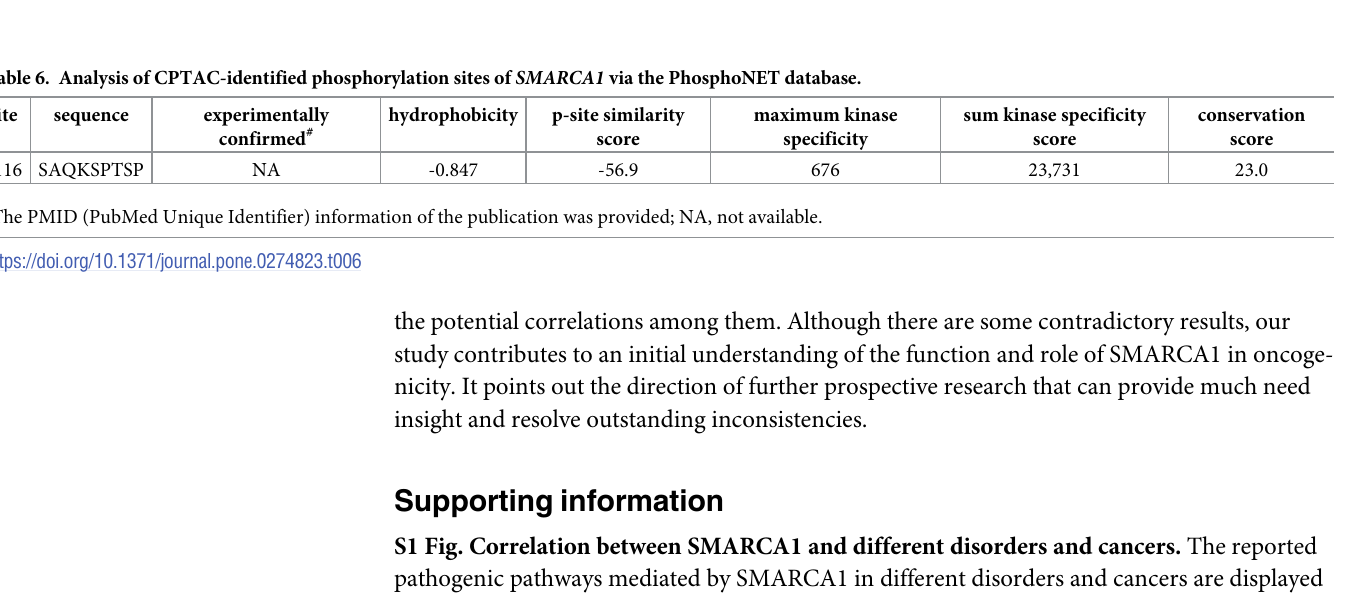
S1 Fig. Correlation between SMARCA1 and different disorders and cancers. The reported pathogenic pathways mediated by SMARCA1 in different disorders and cancers are displayed